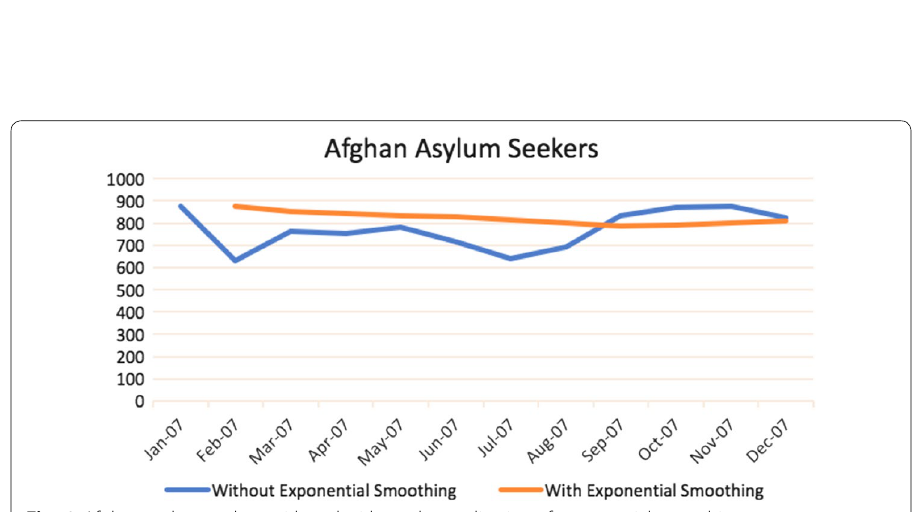
Fig. 6 Afghan asylum seekers with and without the application of exponential